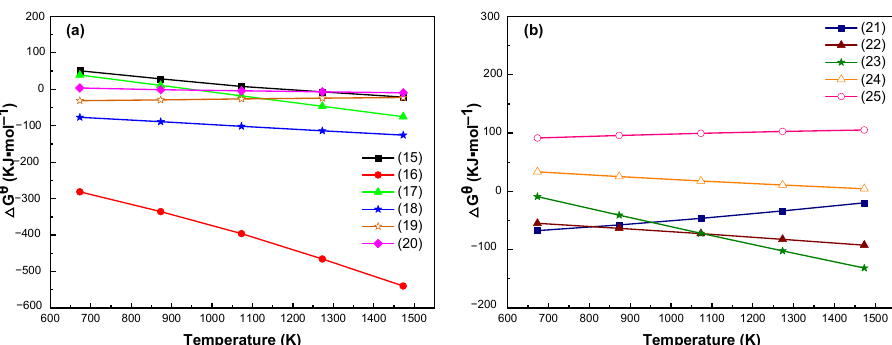
Figure 10. Correlation of standard Gibbs free energy ( ∆ G θ ) with temperature for Reactions ( a ) Reactions (15)–(20); ( b ) Reactions (21)–(25).